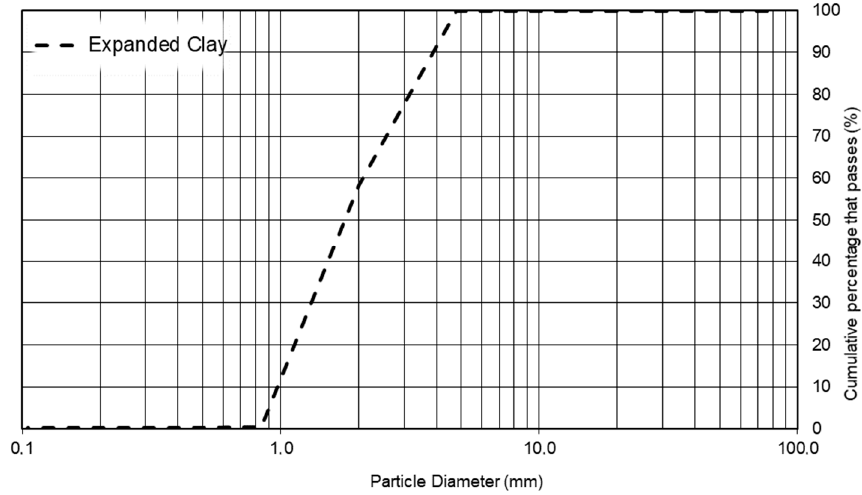
Figure 2. Aggregate’s grain size distribution obtained using the procedure described in EN 933-1 [37].